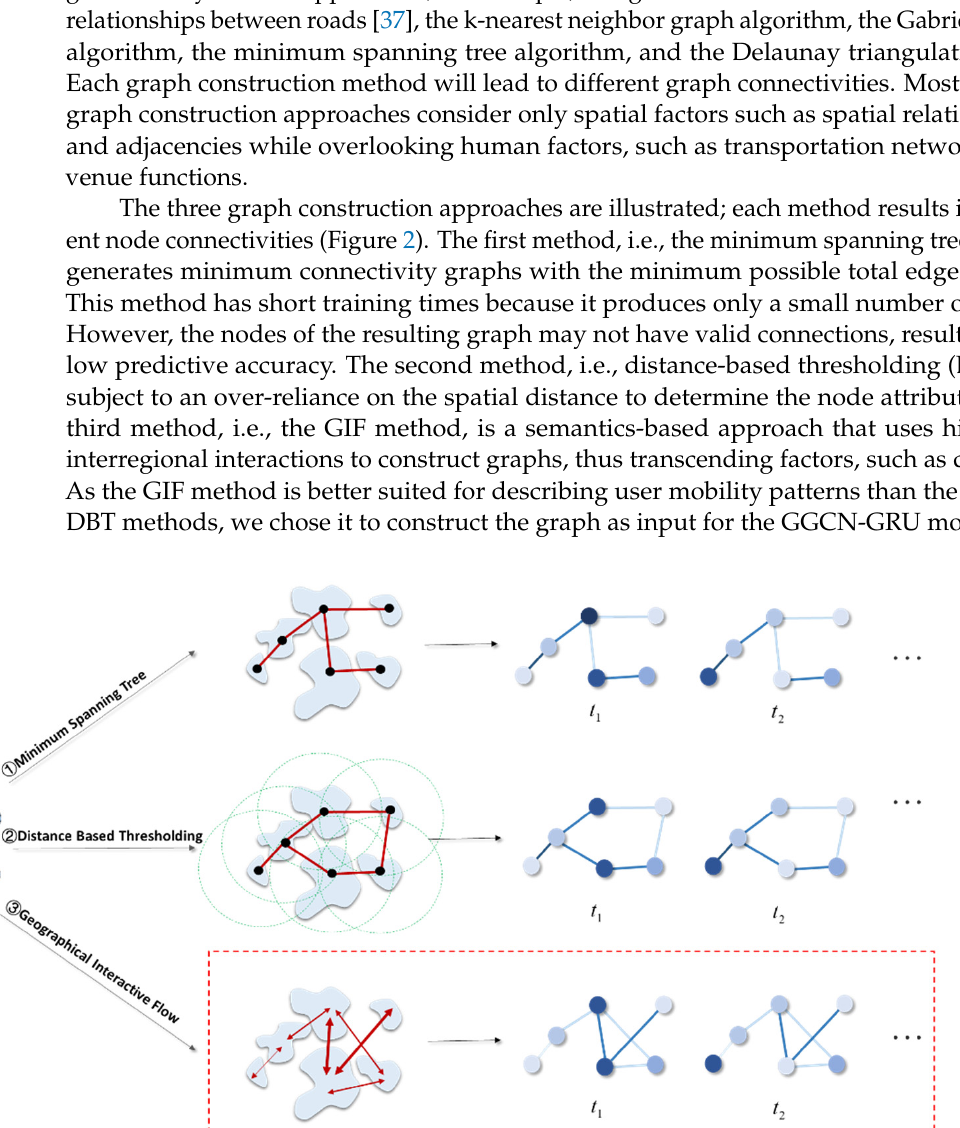
Figure 1. Architecture of the geographical interactions weighted graph convolutional network-gated recurrent unit